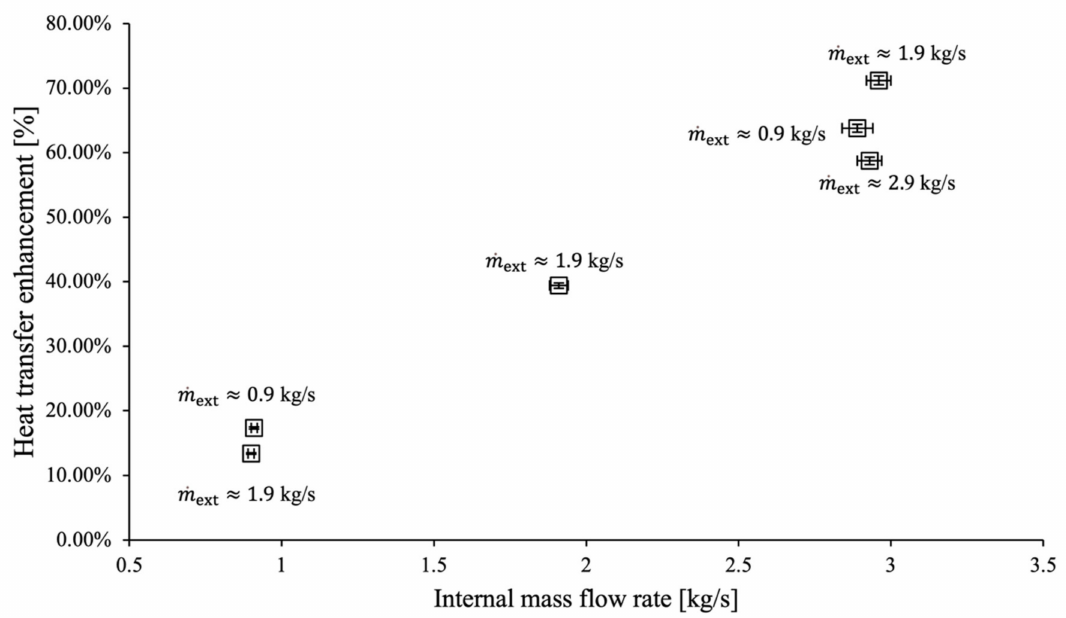
Figure 5. Heat transfer enhancement plotted versus the internal mass flow rate. (The external mass flow rates are shown next to each data